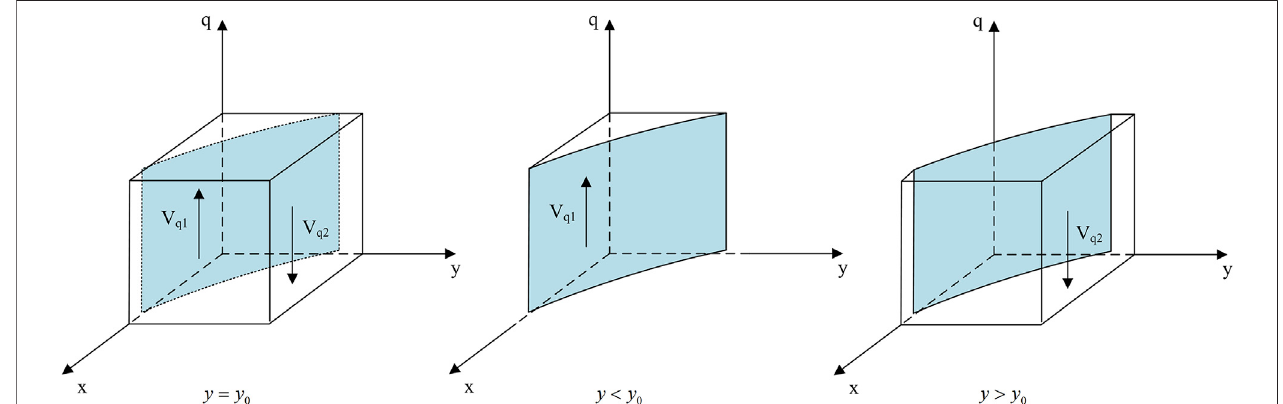
FIGURE 5 | The strategic choices of